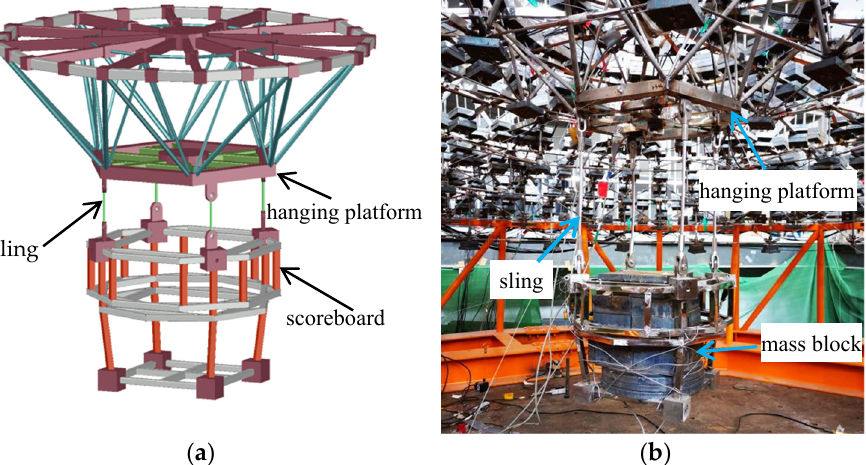
Figure 6. Center-hung scoreboard: ( a ) Scoreboard structural drawing; ( b ) Scoreboard test model. The lower part of the model is a steel column-ring beam supporting system, all made of Q345 steel; the ring beam is a box-shaped section with a side length of 50 mm and a thickness of 2 mm, the steel columns and diagonal braces are circular pipe sections with a diameter of 48 mm and a thickness of 2.8 mm, and the height of the steel column is 0.98 m. The bottom of the column was welded to a steel base similar to a rigid body, and M20 bolts were used to connect the base to the shaking table. Since Asia, especially China, is located at the intersection of the two major seismic zones in the world, the Pacific Rim seismic zone and the Eurasian seismic zone, earthquake disasters are prone to occur [35]. Meanwhile, according to the Chinese Code [36–37], the dead and live roof loads of the prototype structure were designed as 1.2 kN/m 2 and 0.5 kN/m 2 , respectively. After considering the similarity ratio of 1:1.5, the test model roof’s dead and live loads were 0.8 kN/m 2 and 0.33 kN/m 2 , respectively. All loads were set by applying mass blocks on the model nodes or in the middle of bars, as shown in Figure 7a,b, and the assembled model is shown in Figure 7c.